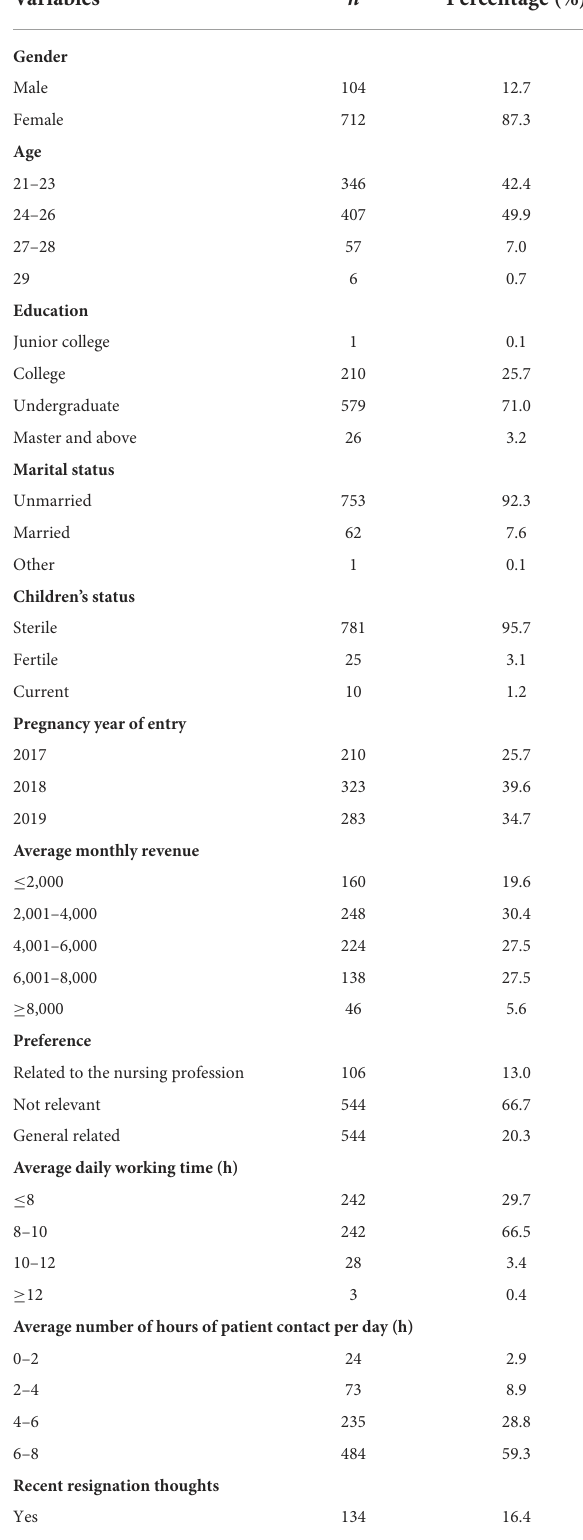
TABLE 1 General information of new nurses ( n =